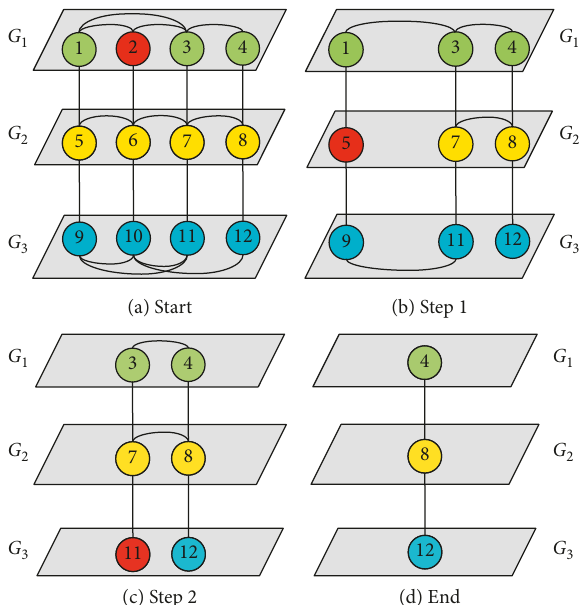
Figure 3: Network model for depicting the cascading failures of a multilayer network subject to node attacks. Networks G G are with one-to-one correlations. (a) Node 2 of network G 3 originally attacked. (b) The failure of node 2 leads to the failures of nodes 6 and 10 due to interdependency. (c) The model posits that, for each network, only nodes in the LCC will be considered as functional, and therefore, nodes 1, 5, and 9 are removed. (d) As a consequence, the failure of node 2 eventually leads to the existence of only three nodes (4, 8, and 12 or 3, 7, and 11).